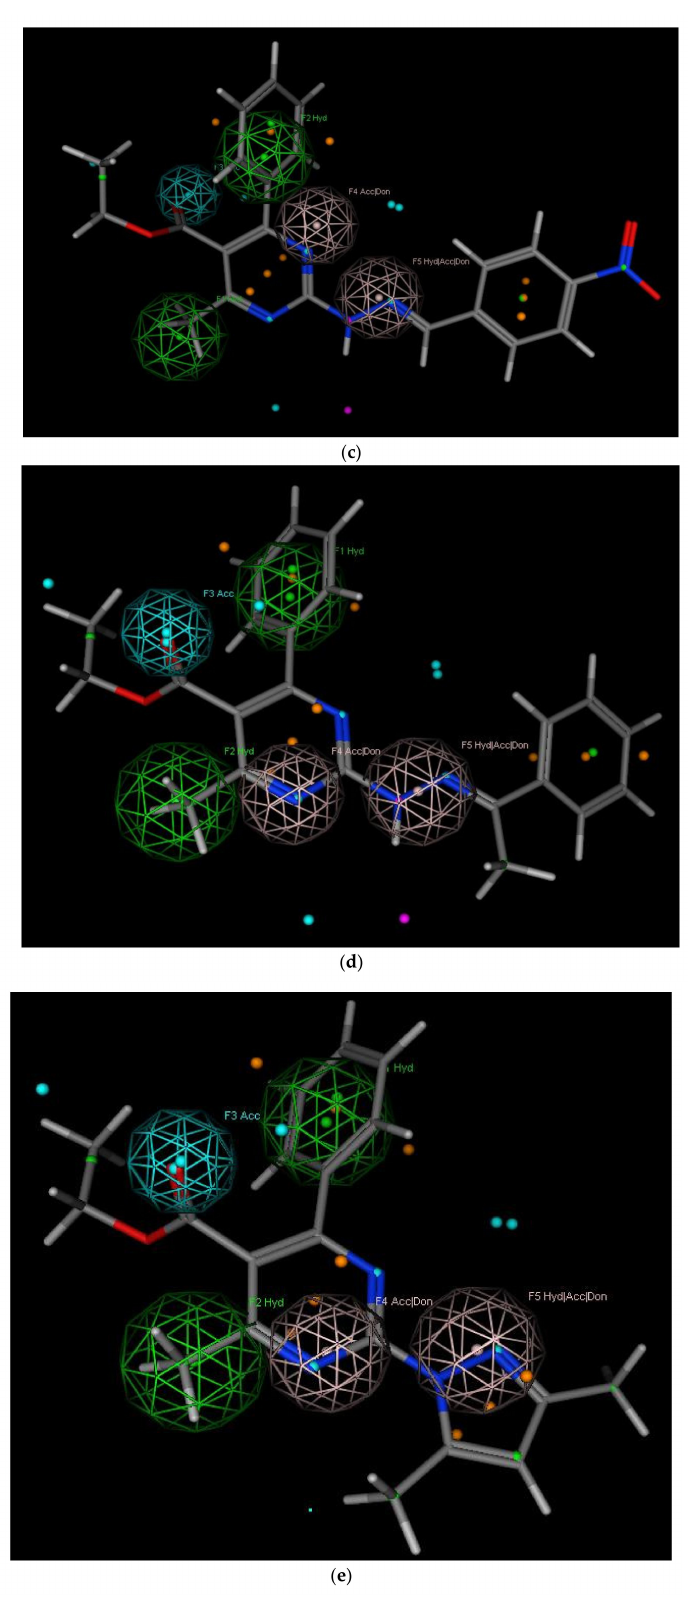
Figure 5. ( a ) Mapping of compound 2 on the pharmacophore model. ( b ) Mapping of compound 3a on the pharmacophore model. ( c ) Mapping of compound 3b on the pharmacophore model. ( d ) Mapping of compound 4 on the pharmacophore model. ( e ) Mapping of compound 11 on